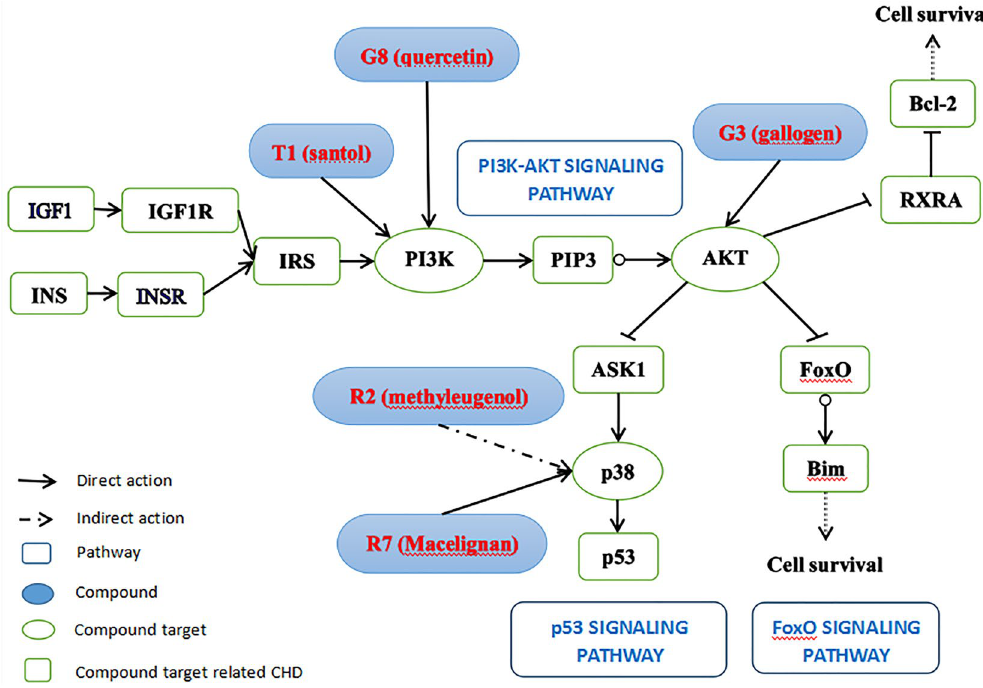
Figure 7. The relation between G3, G8, R2, R7, T1 and the regulated